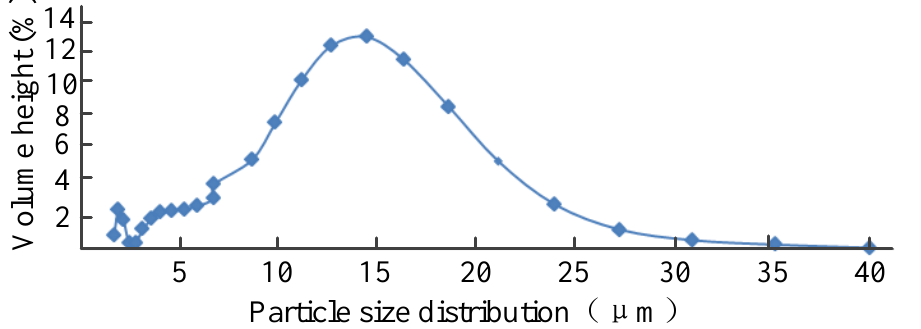
Figure 3. Particle size distribution of starch.